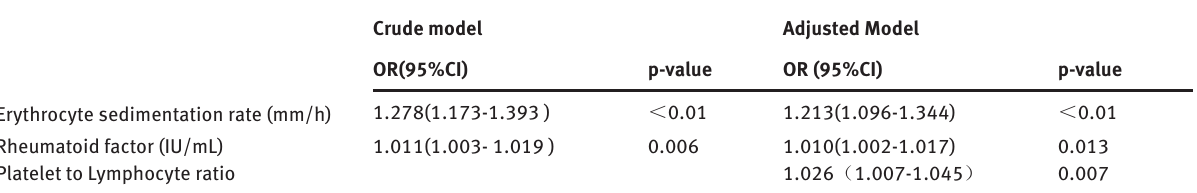
Table 2: Stepwise Logistic regression analysis of inflammation factors associated rheumatoid arthritis